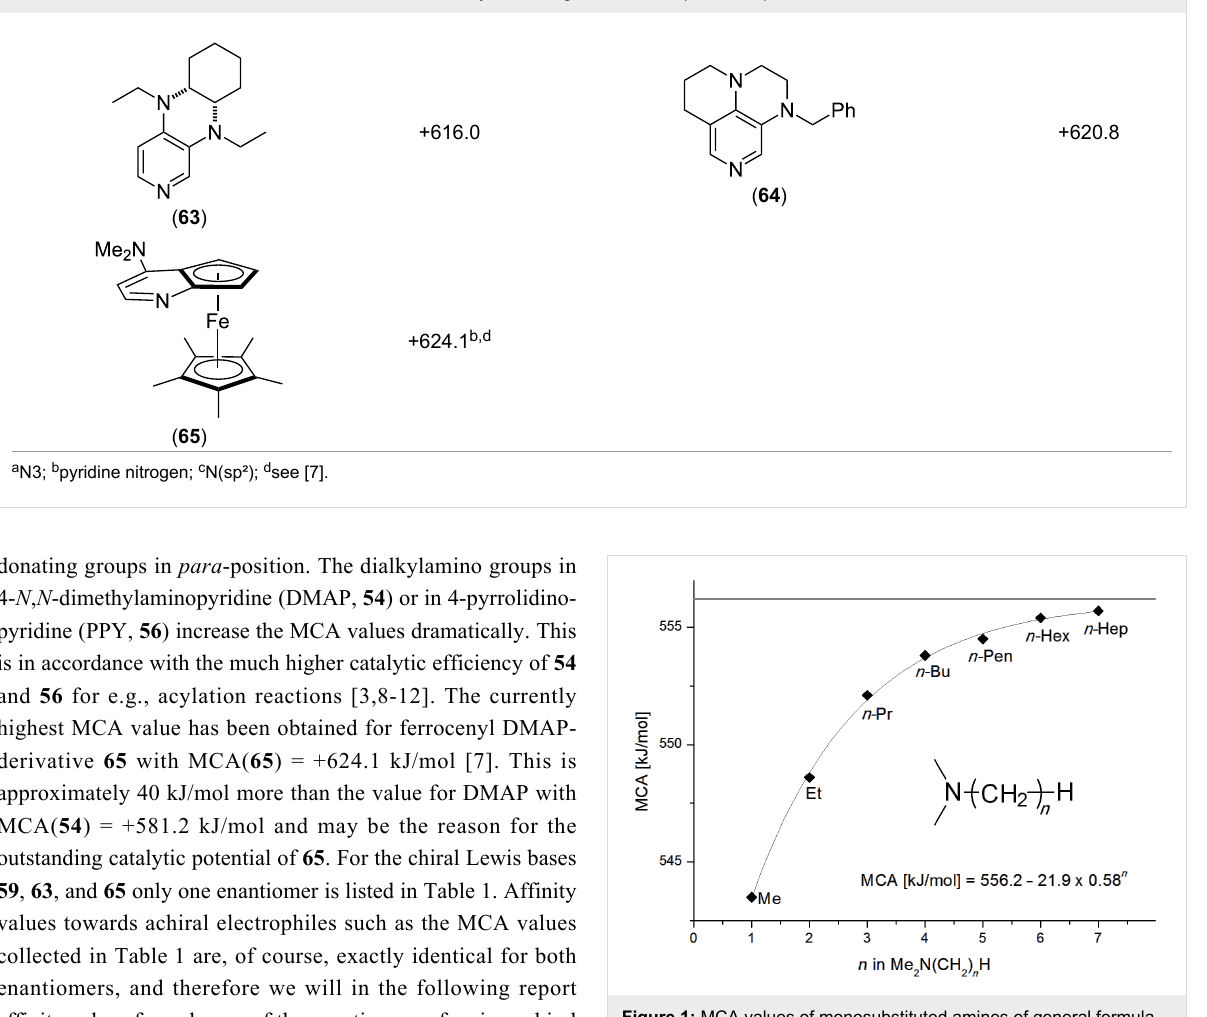
Table 1: MCA values for N-centered Lewis bases, ordered by increasing MCA values. (continued)